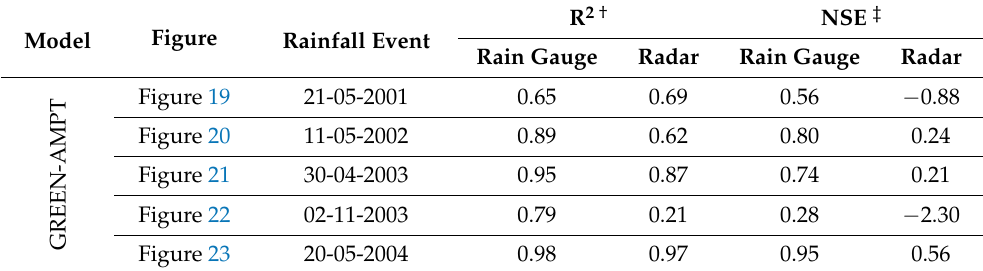
† coefficient of determination; ‡ Nash–Sutcliffe efficiency Table 15. Overall statistical comparison, Root Mean Squared Error, Standard Deviation, RMSE observations Standard Deviation Ratio (RSR), of stream flow using SCS curve number method and Green and Ampt method using different rainfall inputs. † Root Mean Squared Error. ‡ Standard Deviation. ¥ RMSE-observations Standard Deviation Ratio (RSR).